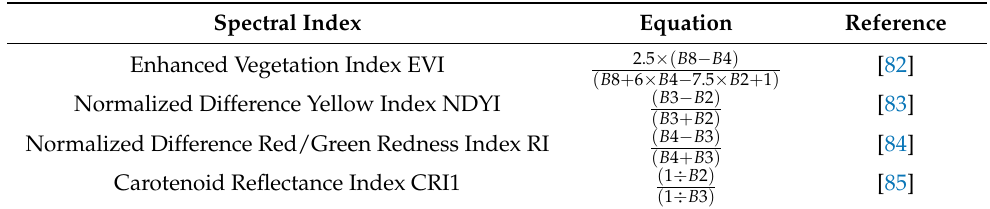
Table 2. Spectral indices adopted, equation with Sentinel-2 Multispectral Instrument (MSI) bands, and bibliographic